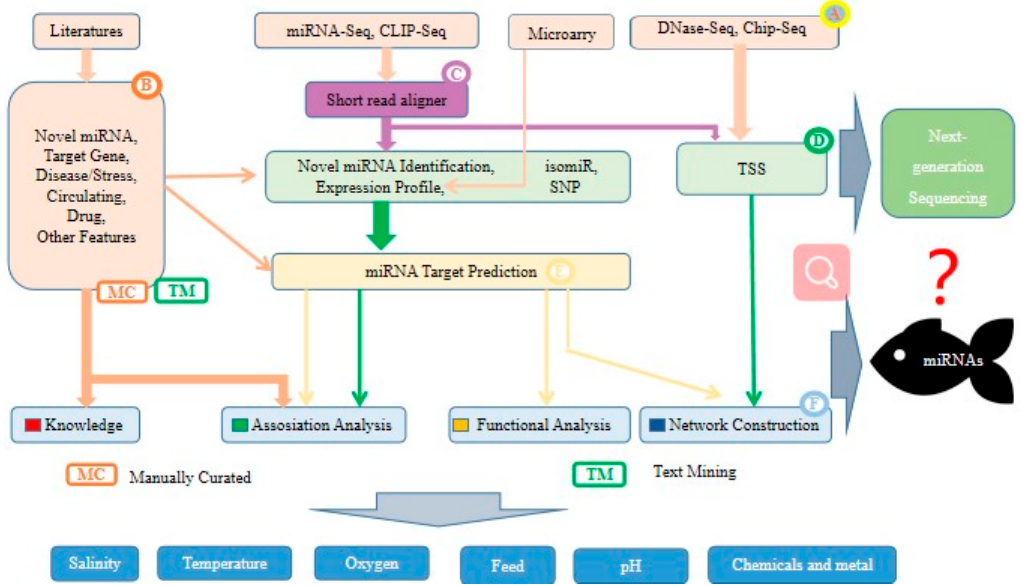
Figure 6. Standard analysis process and prospect of environment-related miRNAs in fish. (A) Data sets download, (B) search of background knowledge, (C) read alignment, (D) identification and characterization of known and novel miRNAs, (E) target prediction, (F) downstream analysis. Funding: This research received no external funding.